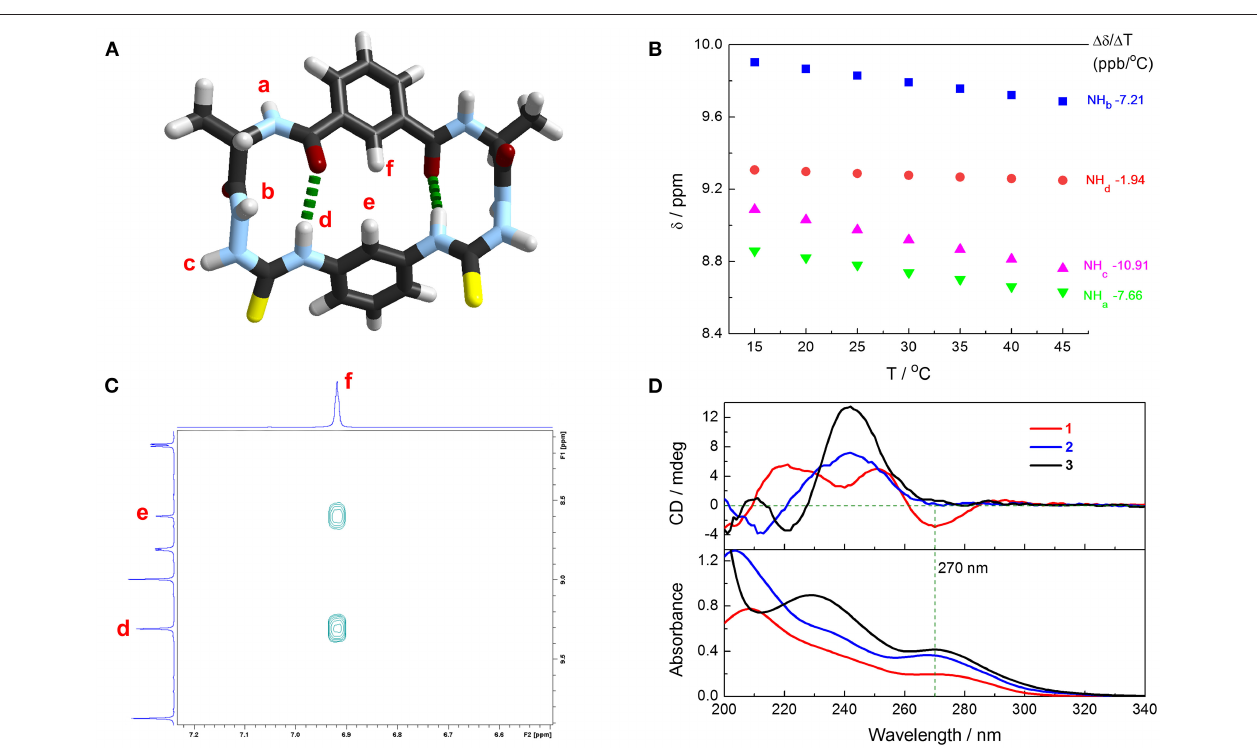
times in reverse-phase HPLC ( Supplementary Table 1 ). This could be a potential advantage of 1 for anion transmembrane transport (Valkenier et al.,